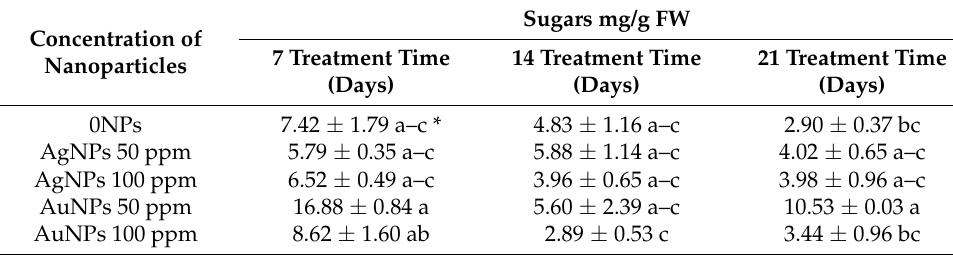
Table 5. Comparison of the influence of nanoparticles’ type and concentration on the free sugars content in rapeseed